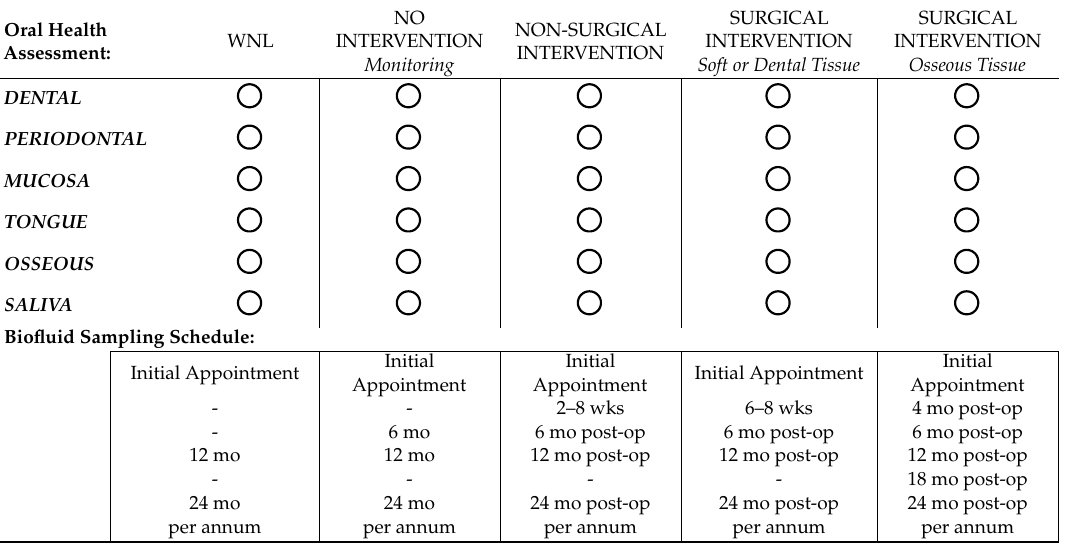
Table 2. Proposed oral biofluid sampling schedule. WNL, within normal limits.